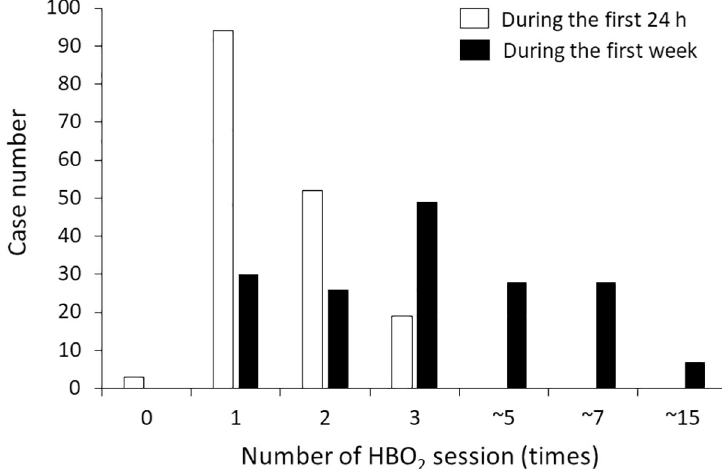
Fig 2. Number of HBO 2 session during the first 24 h and the first week in the HBO 2 group.